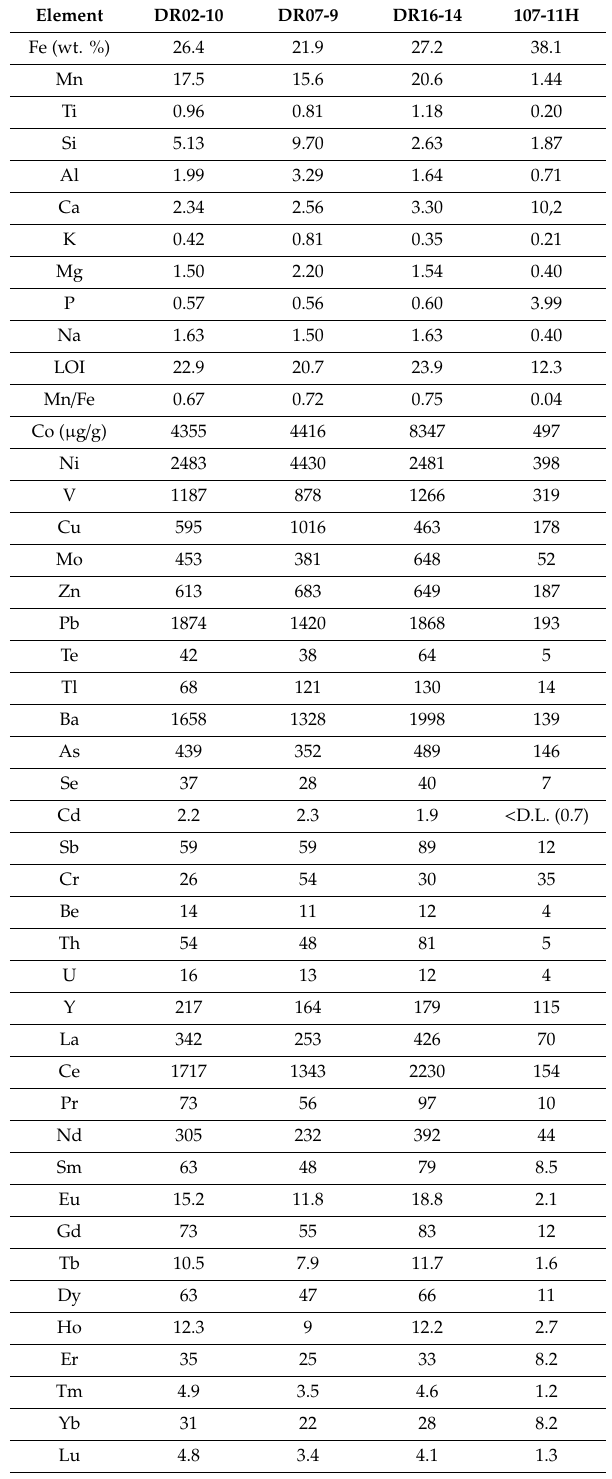
Table 3. Elemental content of selected bulk samples from CISP normalized to 0% H 2 O. LOI = Loss on Ignition, D.L. = detection